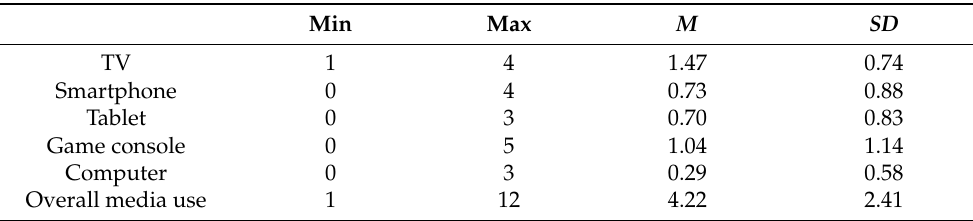
Table 1. Descriptive statistics of media use in hours per